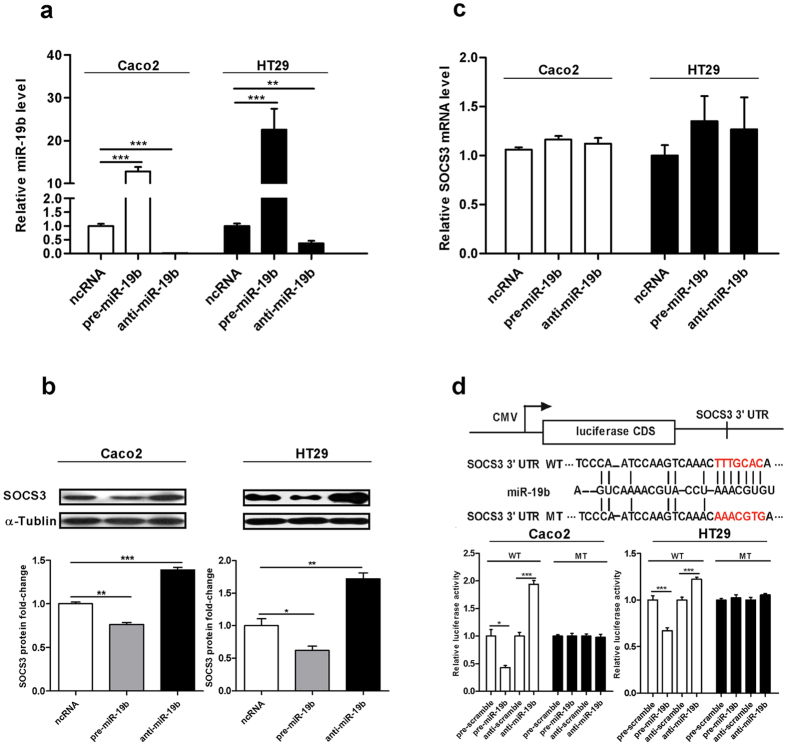
Validation of human SOCS3 as a direct miR-19b target.(a), Quantitative real-time PCR analysis of miR-19b expression in Caco2 cells and HT29 cells transfected with pre-miR-19b, anti-miR-19b or ncRNA. Left: Caco2 cells. Right: HT29 cells. Data are presented as the mean±SEM from three independent experiments (Caco2 group: ***p = 0.000092, ncRNA vs. pre-miR-19b, ***p = 0.000031, ncRNA vs. anti-miR-19b; HT29 group: ***p = 0.000253, ncRNA vs. pre-miR-19b,**p = 0.003, ncRNA vs. anti-miR-19b). (b), Immunoblot for endogenous SOCS3 in Caco2 cells and HT29 cells transfected with pre-miR-19b, anti-miR-19b or ncRNA. Left: Caco2 cells. Right: HT29 cells. α-Tubulin was used as a loading control. Top panel: representative image; Bottom panel: quantitative analysis. The original whole-blot pictures are available in Supplementary Fig. S6. Results are presented as the mean±SEM from three independent experiments (Caco2 group: **p = 0.0014, ncRNA vs. pre-miR-19b,***p = 0.00036,ncRNA vs. anti-miR-19b; HT29 group: *p = 0.038, ncRNA vs. pre-miR-19b,**p = 0.007, ncRNA vs. anti-miR-19b). (c), Quantitative real-time PCR analysis of SOCS3 expression in Caco2 cells and HT29 cells treated with pre-miR-19b, anti-miR-19b or ncRNA. Left: Caco2 cells. Right: HT29 cells. The y-axis shows relative SOCS3 mRNA levels normalized to GAPDH. The results are presented as the mean±SEM from three independent experiments (p > 0.05 vs. ncRNA). (d), Direct recognition of the SOCS3 3’-UTR by miR-19b. Firefly luciferase reporters containing wild-type (WT) or mutant (MT) miR-19b binding sites in the SOCS3 3’-UTR were co-transfected into Caco2 cells and HT29 cells with scrambled ncRNA, pre-miR-19b or anti-miR-19b. Twenty-four hours after transfection, a luciferase assay was performed. Firefly luciferase values were normalized to β-galactosidase activity and plotted as relative luciferase activity. The results were calculated as the ratio of firefly luciferase activity in miR-19b-transfected cells to the luciferase activity in control cells. Left: Caco2 cells. Right: HT29 cells. The results are presented as the mean±SEM from three independent experiments (Caco2 group: *p = 0.013, pre-scramble vs. pre-miR-19b,***p = 0.0000, anti-scramble vs. anti-miR-19b; HT29 group:***p = 0.000021, pre-scramble vs. pre-miR-19b,***p = 0.000019, anti-scramble vs. anti-miR-19b).